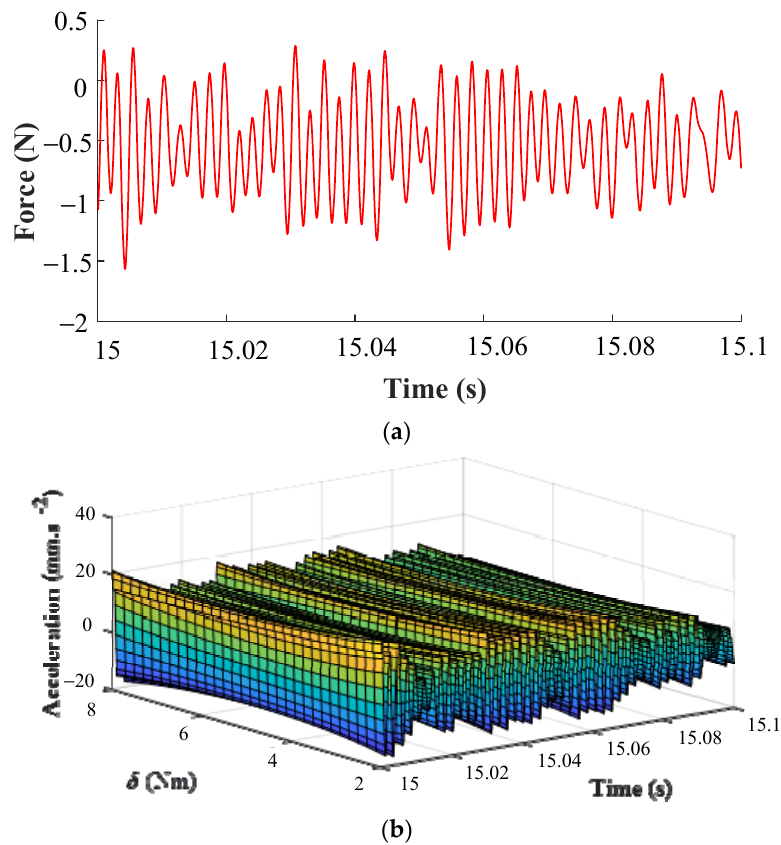
Figure 12. The WEFOR output obtained by using MPO of δ = [2:0.2:8] Nm. ( a ) System input and ( b ) System output.